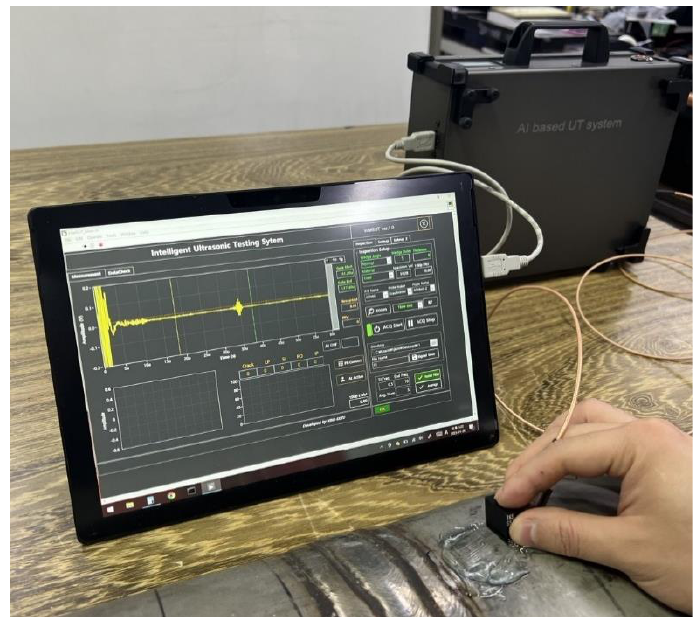
Figure 3. Digitalized UT system and inspection of pipe weldment specimen.